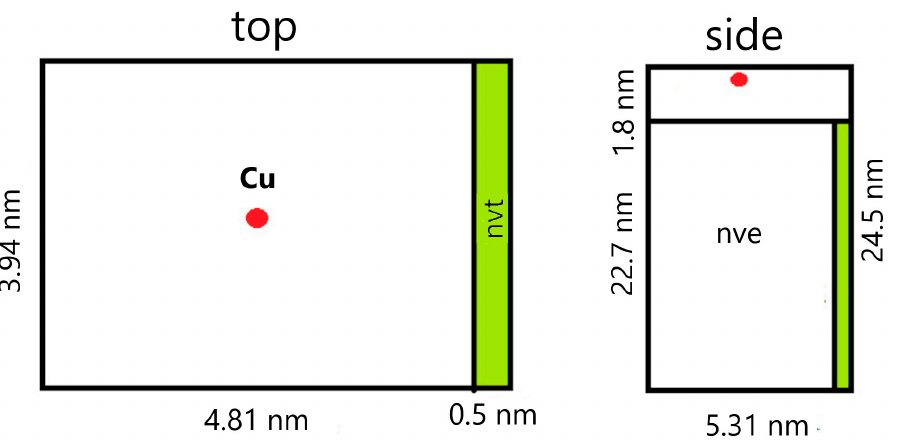
Figure 2. A diagram of a model with characteristic dimensions. To simulate the dissipation of energy into an infinite volume of material, a 0.5 nm thick region was isolated from the side of the PCL slab to the atoms of which temperature control was applied (NVT thermostat, T = 300 K). An NVE thermostat was applied to the remaining atoms of the system, including the metal atom. The simulation continued until the energy of the metal atom exceeded the average thermal energy of the PCL slab. The energies of a swooped Cu atom in the range from 500 eV to 2400 eV were considered. For each selected energy, a series of computer experiments were made, consisting of five simulations. The average values are shown in Figure 3.